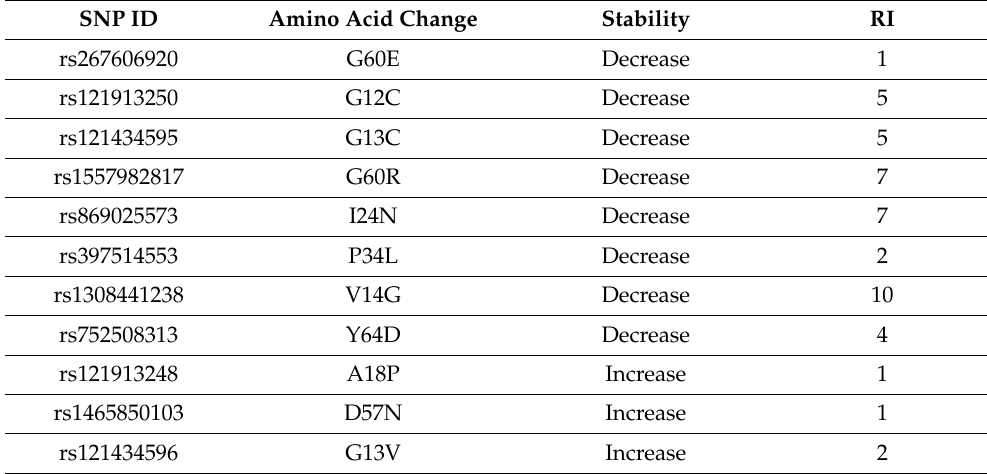
Table 2. Stability prediction of mutated NRAS protein using